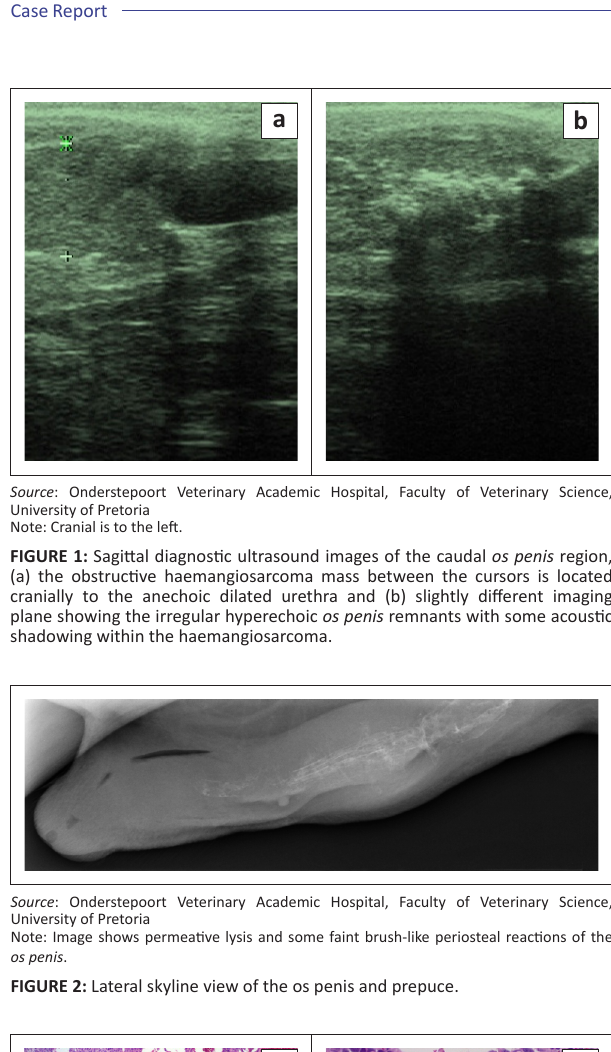
FIGURE 2: Lateral skyline view of the os penis and prepuce.